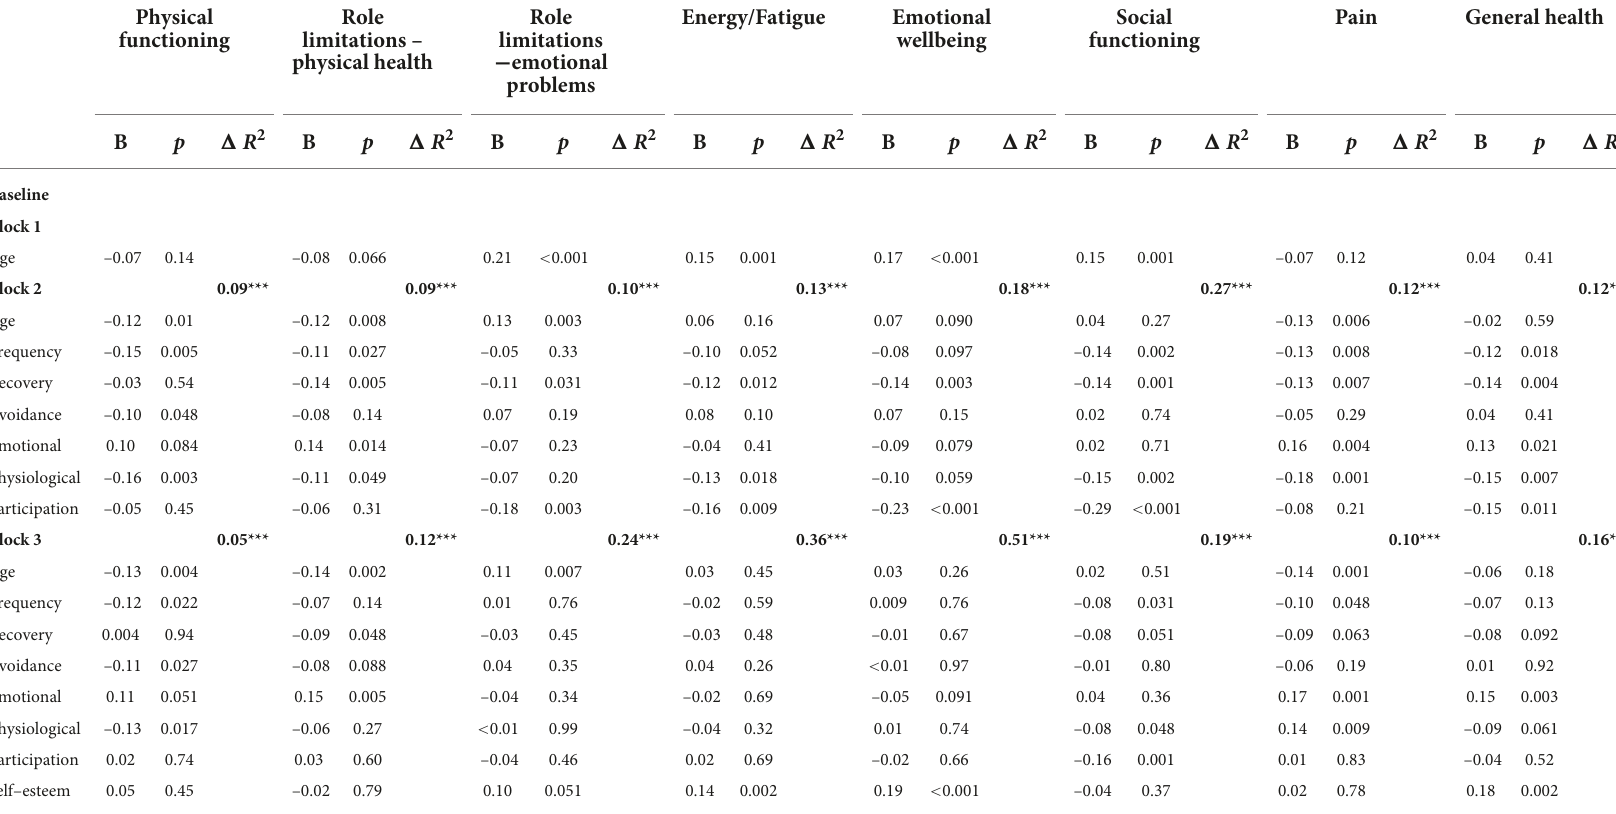
TABLE 11 Summary of hierarchical regression models for predicting quality of life cross-sectionally (at baseline) and longitudinally (at follow-up) in misophonia